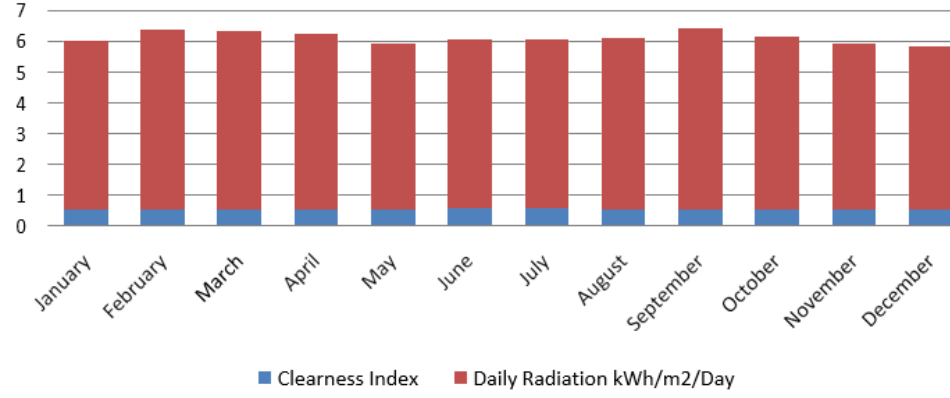
Figure 2. Average solar radiation and clearness index.